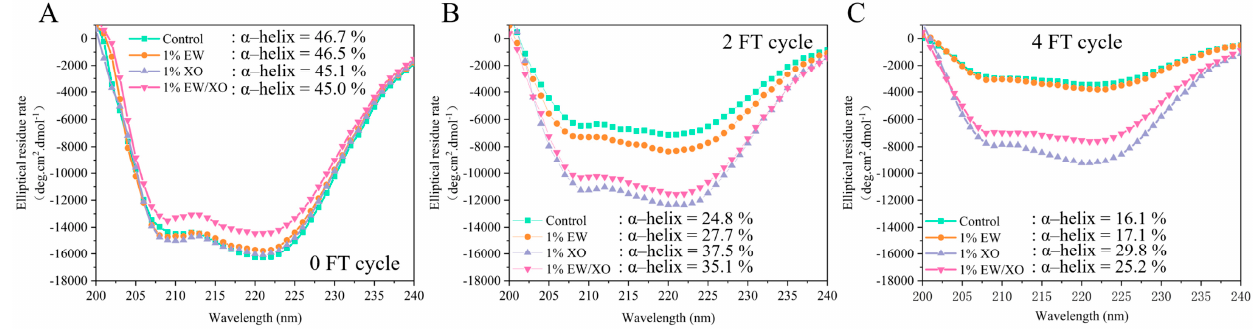
Fig. 2 Changes of Far-UV in Culter alburnus myofibrillar protein added with EW, XO or XO/EW after 0 (A),2(B), and 4(C) freeze-thaw cycles. The control Figure 2. Changes of Far-UV in Culter alburnus myofibrillar protein added with EW, XO, or XO/EW after 0 ( A ), 2 ( B ), and group (Control) was not added with EW,XO or XO/EW. 4 ( C ) freeze-thaw cycles. The control group (Control) was not added with EW, XO, or